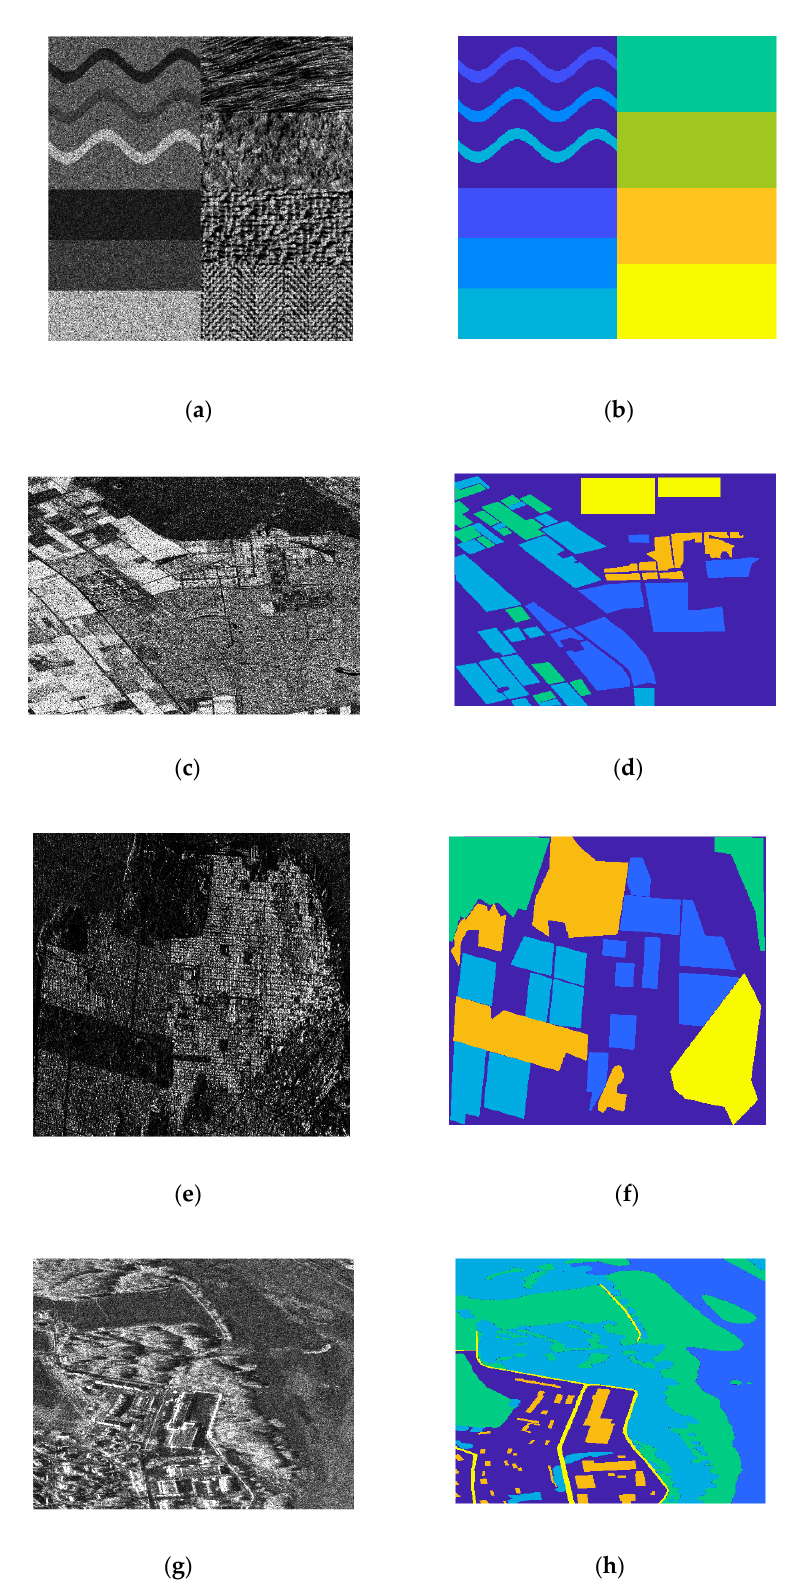
Figure 4. SAR images and the corresponding ground truth. ( a ) The synthetic SAR image. ( b ) Ground truth for the synthetic SAR image. ( c ) The Flevoland image. ( d ) Ground truth for the Flevoland image. ( e ) The SF-Bay image. ( f ) Ground truth for the SF-Bay image. ( g ) The Lillestroem image. ( h ) Ground truth for the Lillestroem